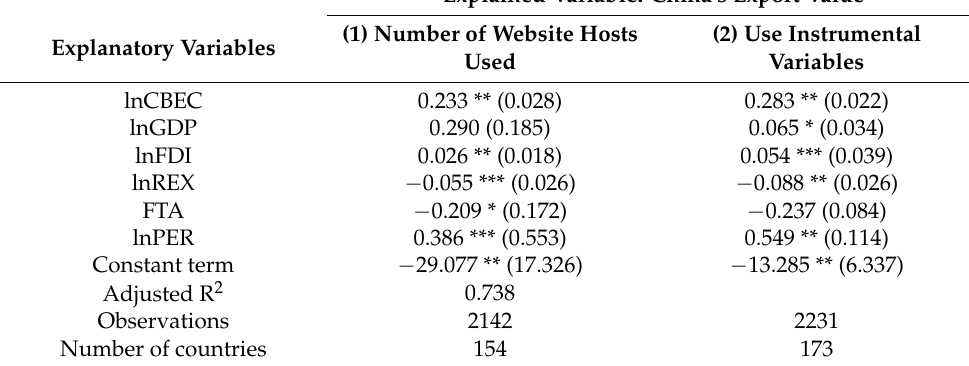
Table 5. Robustness test